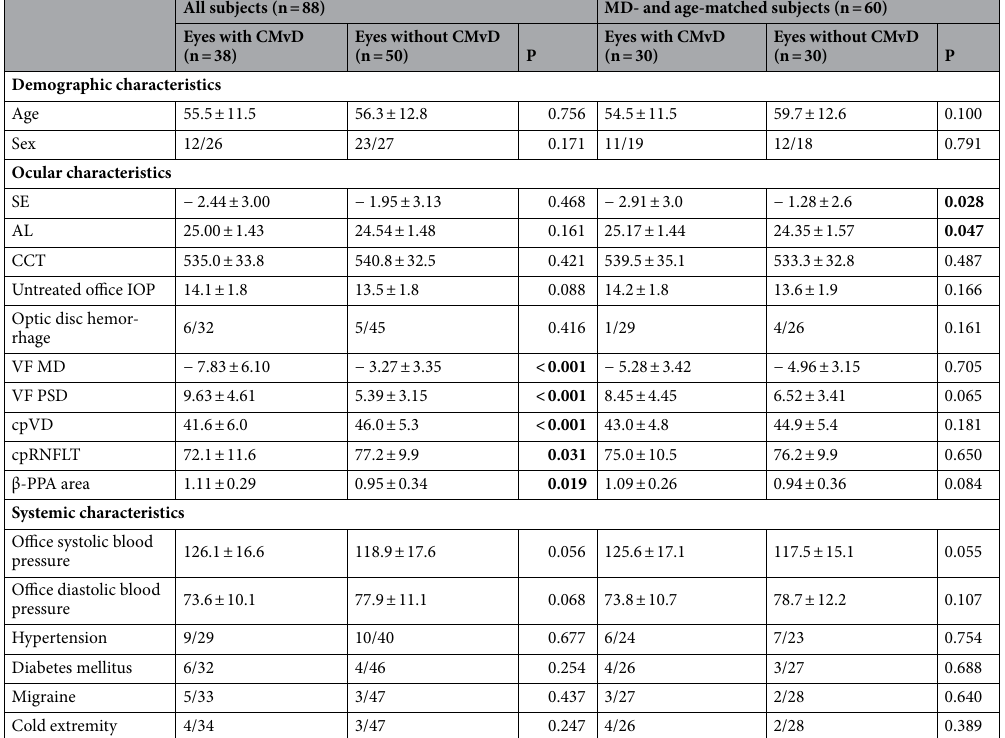
Table 1. Clinical characteristics of eyes with and without choroidal microvasculature dropout (CMvD) in normal-tension glaucoma. Statistically significant differences are shown in bold. MD mean deviation, SE spherical equivalent, AL axial length, CCT central corneal thickness, IOP intraocular pressure, VF visual field, PSD pattern standard deviation, VD vessel density, cpVD circumpapillary vessel density,